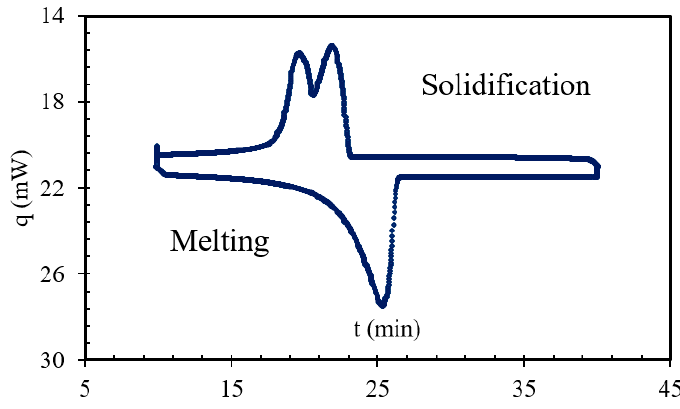
Figure 13. DSC analysis: representative response of wood impregnated with PCM.